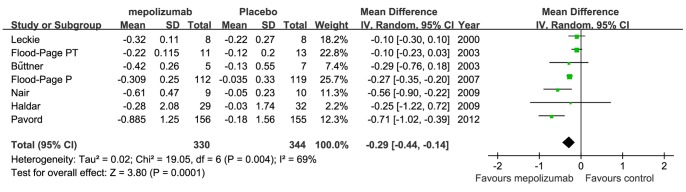
The effect of mepolizumab on blood eosinophils (×109/L).